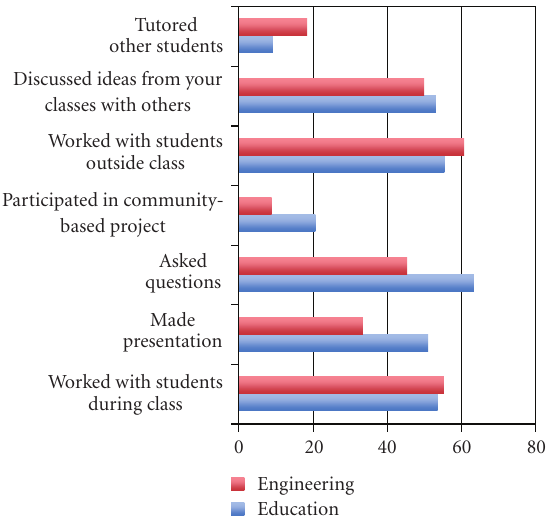
Figure 1: Observed di ff erences in active learning engagement items between Engineering and Education students in Australian Universities